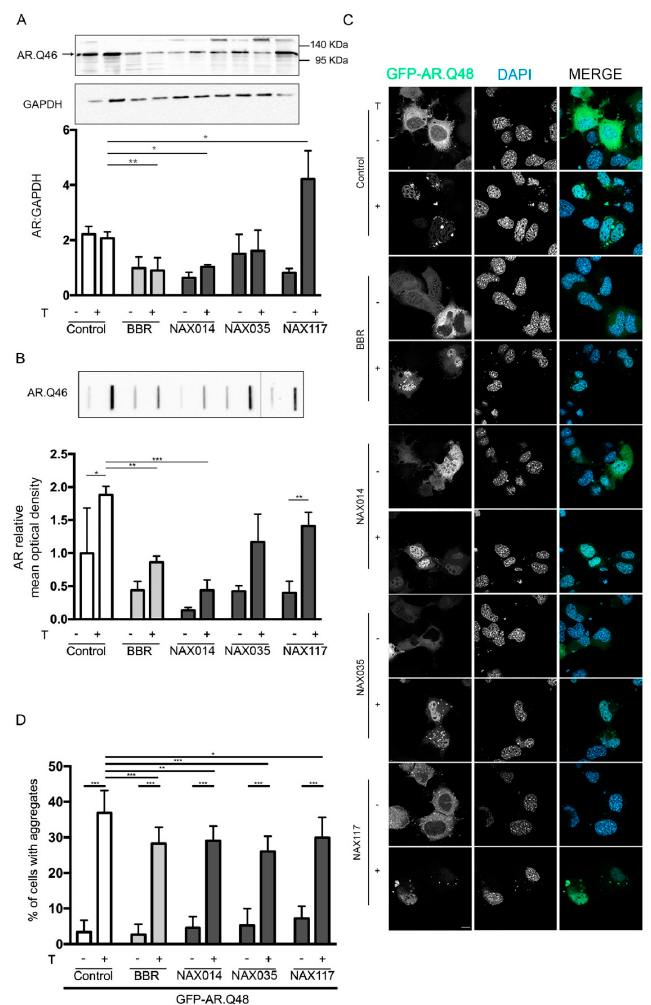
Figure 3. Effects of NAXs on ARpolyQ. (A , B) NSC34 cells were transfected with AR.Q46 in absence or in presence of 10 nM of testosterone and treated with BBR or NAX compounds for 48 h (BBR, NAX014 and NAX035 were used at 0.2 μ M, NAX117 was used at 0.5 μ M). ( A ) WB analysis was performed, GAPDH was used as loading control, the bar graph represents the mean optical density ± SD of AR: GAPDH (n = 3) (* p < 0.05, ** p < 0.01, two-way ANOVA, followed by Tukey’s test). ( B ) FRA was performed. The bar graph represents the mean optical density of AR ± SD (n = 3) (* p < 0.05, ** p < 0.01, *** p < 0.001, two-way ANOVA, followed by Tukey’s test). ( C , D ) Fluorescence microscope analysis performed on NSC34 cells transfected with GFP-ARQ48 in absence or in presence of 10 nM testosterone and treated BBR or NAX compounds for 48 h (BBR, NAX014 and NAX035 were used at 0.2 µ M, NAX117 was used at 0.5 µ M). ( C ) Representative fluorescence microscopy analysis of GFP-AR.Q48 protein levels. Nuclei were stained with DAPI (63X magnification). Scale bar: 10 µ M. ( D ) The quantification of GFP-AR.Q48 aggregates was performed using a PL 10X / 20 eyepiece with graticules. The percentage of cells with aggregates was obtained dividing the number of cells with aggregates with the total number of GFP positive cells (* p < 0.05, ** p < 0.01, *** p < 0.001, two-way ANOVA, followed by Tukey’s